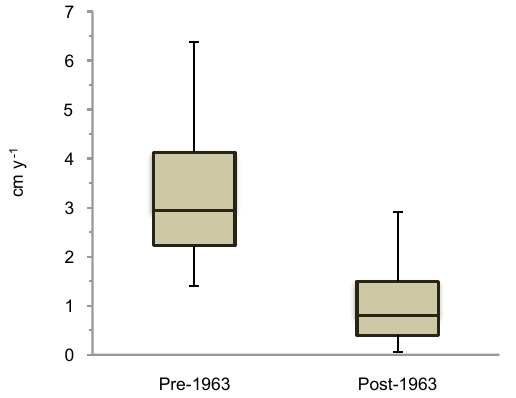
Figure 7. Linear sedimentation rates derived from 137 Cs activities. Summary comparison of pre-1963 and post-1963